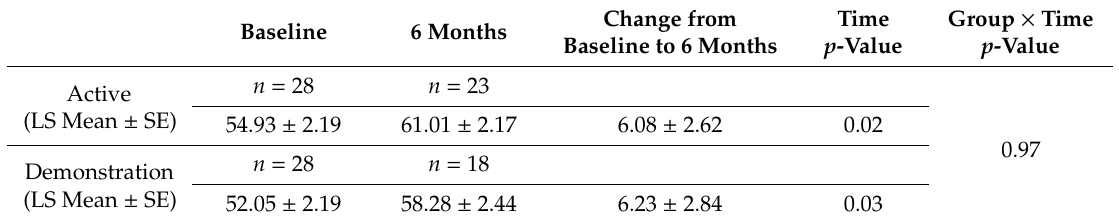
Table 3. Mean healthy eating index scores from baseline to six